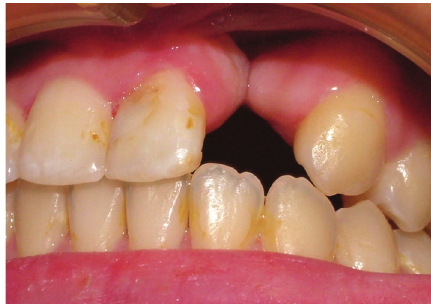
Figure 9: Esthetic view of the final